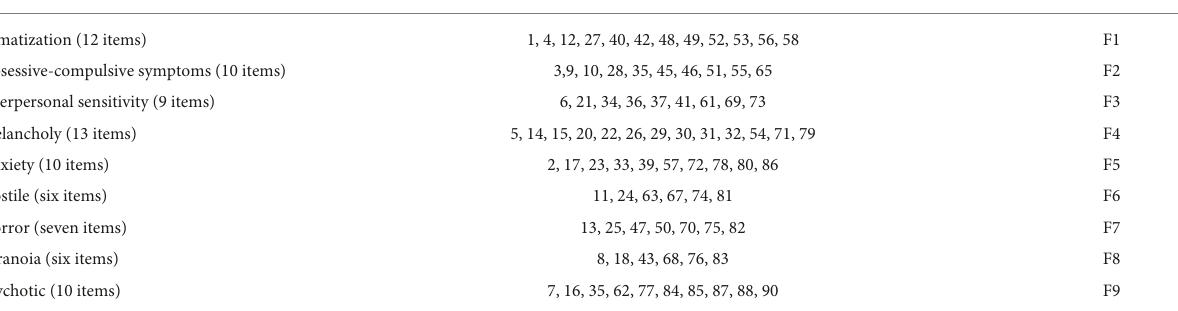
TABLE 1 Average score of SCL-90 scale factors. Factor